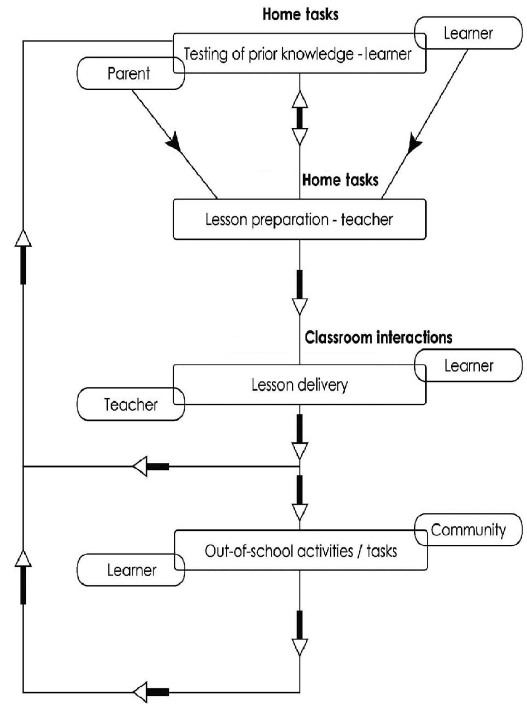
Fig. 2 Paradigm for physics lectures using a multiloop [16] .